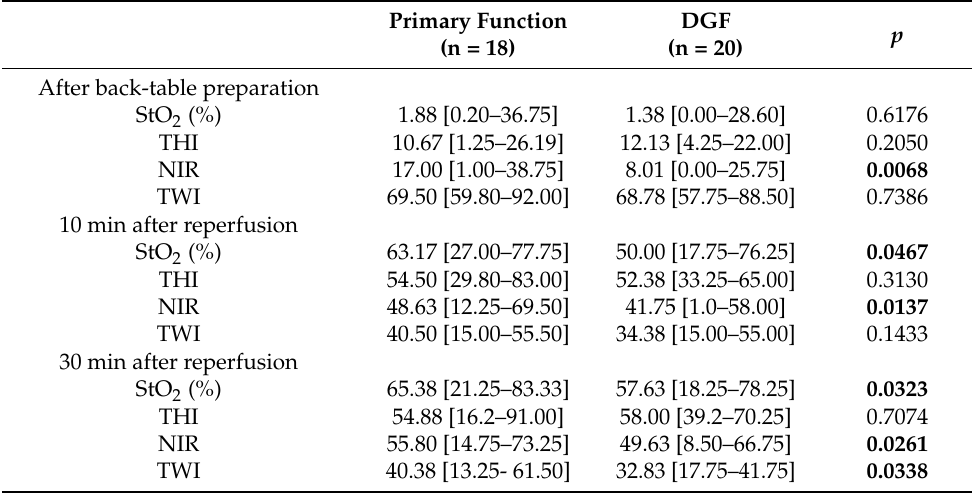
Table 3. HSI parameters stratified according to initial graft function. Primary